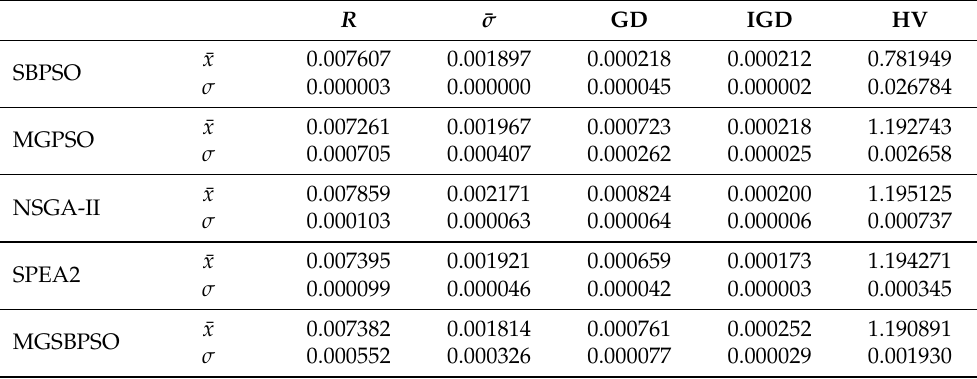
Table 7. DAX 100 results for each performance measure.